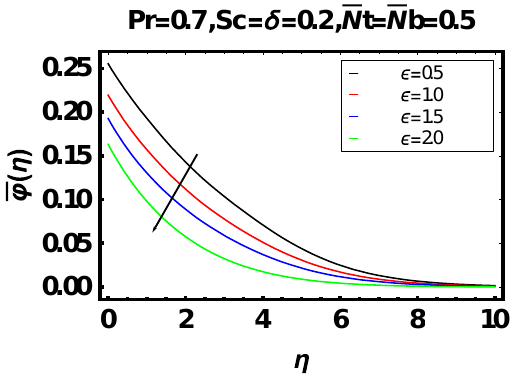
Figure 15. Mass concentration profile for variant (cid:101)